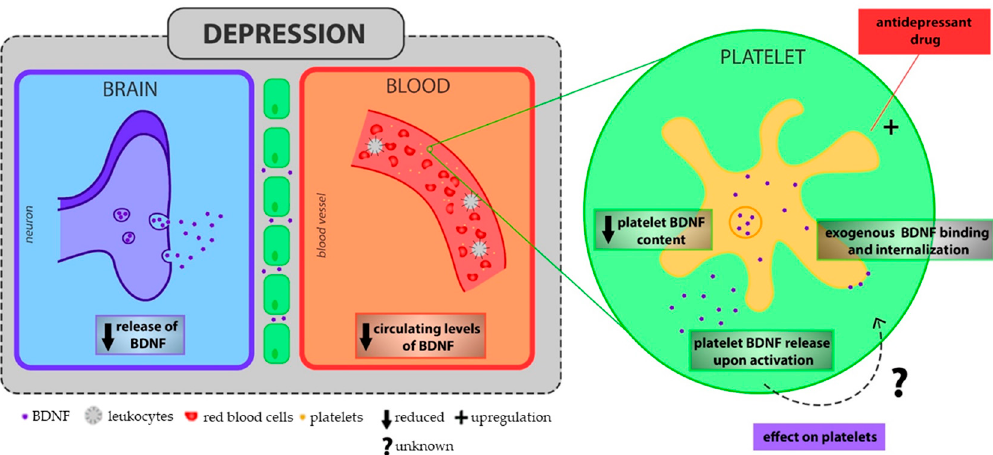
Figure 2. The controversial role of BDNF on platelet function. Depressed patients are characterized by the reduction of BDNF levels in the brain, that is well reflected by its decreased plasma and serum levels [221–223]. Remarkably, platelet BDNF content is reduced in depressed patients [224], but antidepressant treatment is able to restore their levels [224], indicating that a pre-activated state may promote platelet emptying of their BDNF reservoir. Platelets, when activated, can release BDNF [154,215,217,218], and extracellular BDNF can bind a specific site on platelets surface with subsequent internalization [215]. However, there are no information about its possible e ff ect on platelets. BDNF: Brain-derived Neurotrophic